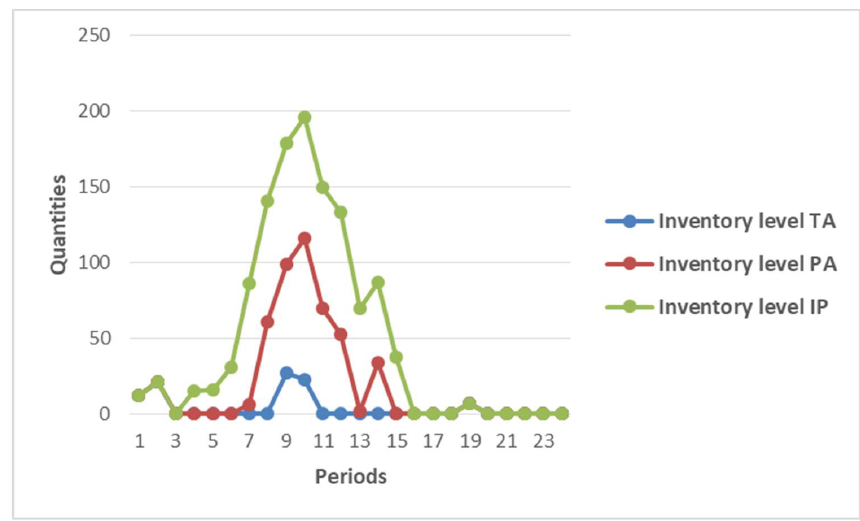
Fig. 3. Evolution of product stocks P over the planning